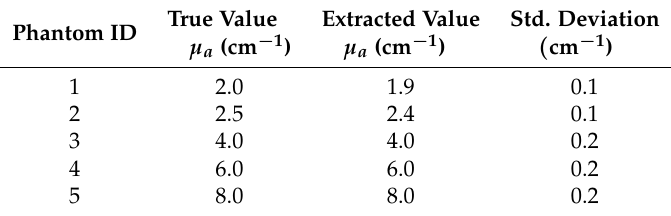
Table 1. Reconstruction of absorption coefficient of the top layer from simulated data with prior knowledge of scattering coefficient of top layer and both optical properties of bottom layer